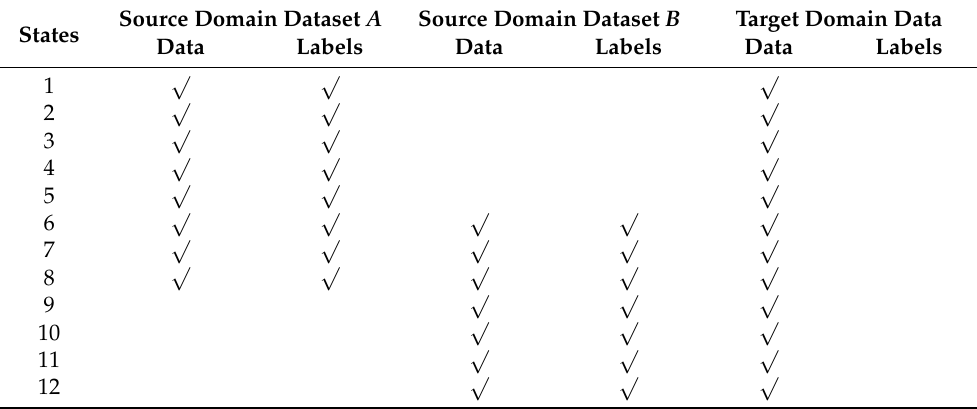
Table 11. Distribution of health states in source and target